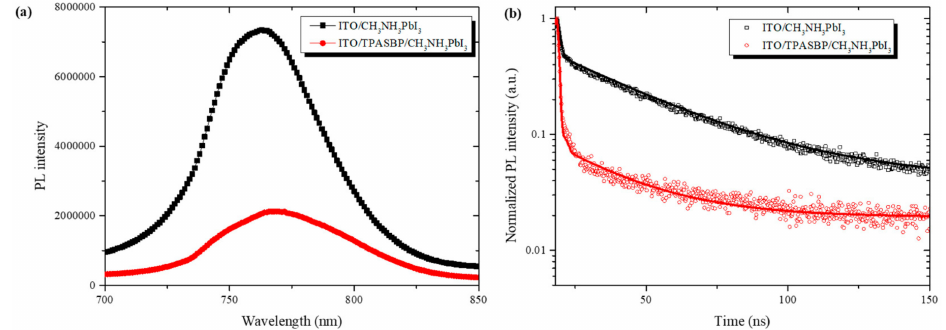
Figure 4. ( a ) Steady-state PL spectra, and ( b ) time-resolved PL (TRPL) decay curves of CH 3 NH 3 PbI 3 films on ITO and ITO / TPASBP